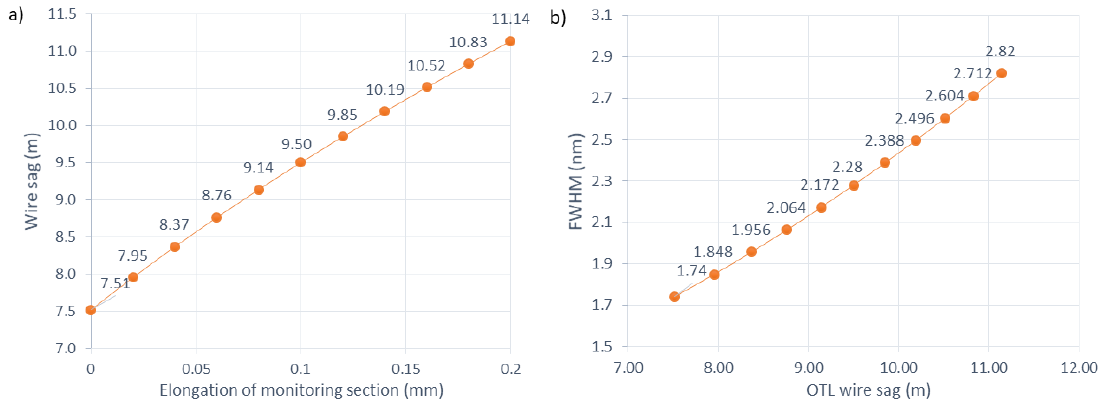
Figure 10. ( a ) The dependency of the OTL wire sag related with the elongation of the proposed measurement system plate calculated for the initial conditions described in Equations (20) and (21); and ( b ) the dependency of the measured FWHM for different sag values of the monitored OTL line.